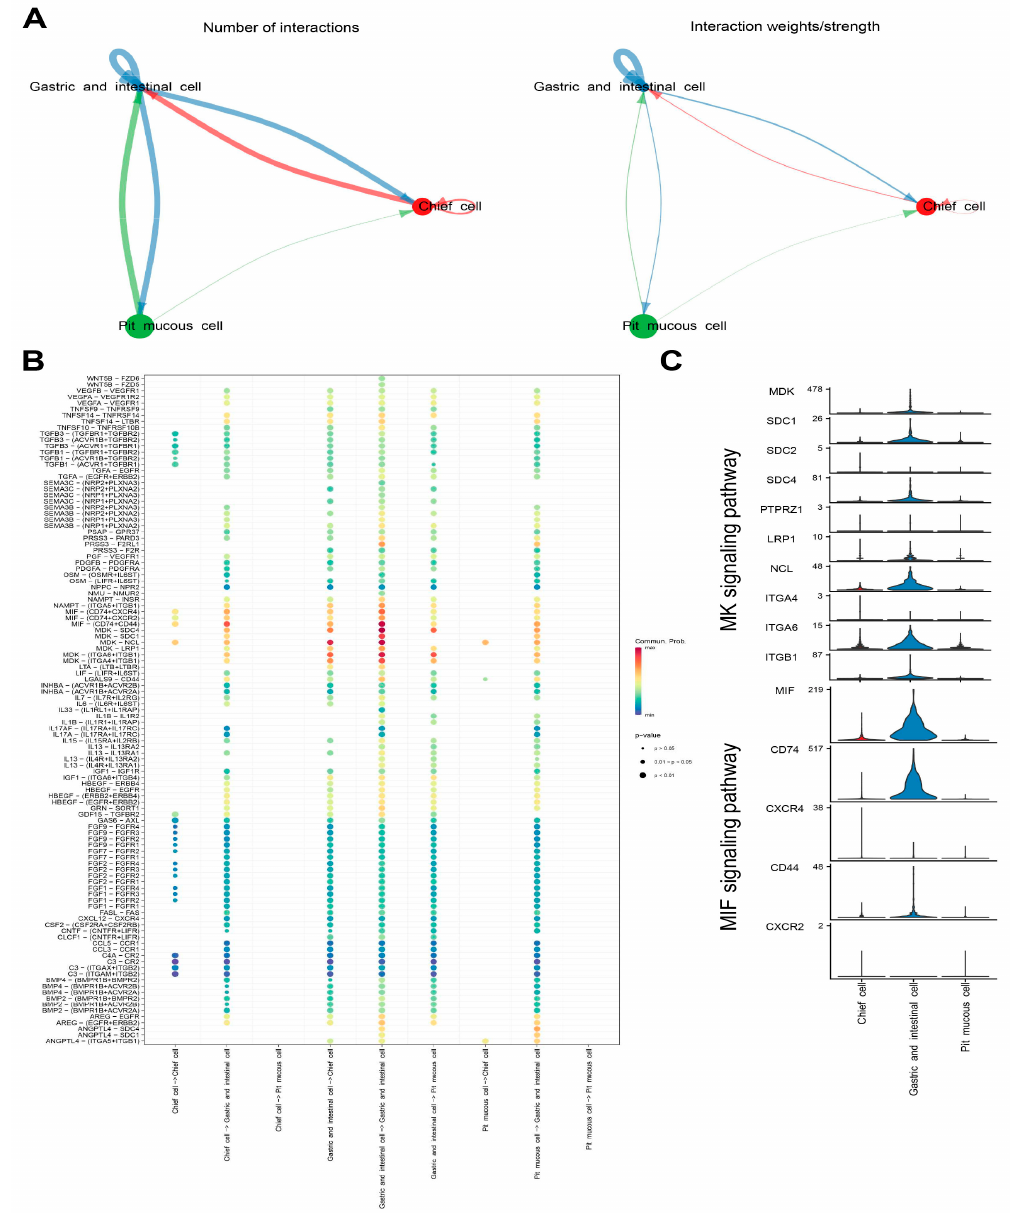
Figure 8. Cell–cell communication analysis of malignant epithelial cells. ( A ) Capacity for intercel- lular communication among the three malignant epithelial cell subtypes. The size of the circle is proportional to the number of cells. The cells that emit arrows express ligands and the cells that arrows point to express receptors. The more ligand–receptor pairs, the thicker the line. ( B ) Bubble plot showing the intercellular interaction relationship mediated by ligand–receptor pairs. ( C ) Violin plots showing the expression of representative genes in the MK and MIF signaling